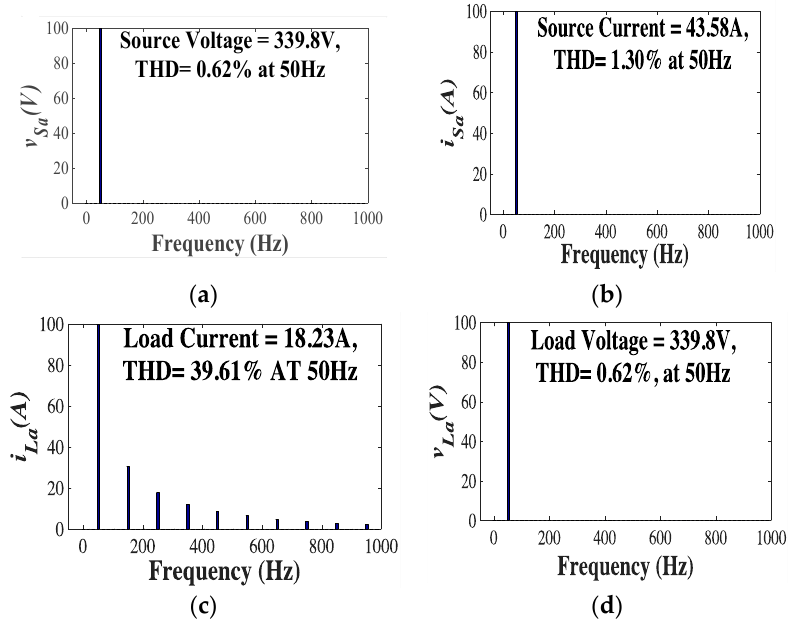
Figure 5. THD analysis of v Sa , i Sa , v La and i La . The comparison of the THD of selected source, load, and compensator signals with various adaptive VSC controls, e.g., MCC, AKWMCC and proposed control, are also presented in Table 1. Table 1. THD comparison of v Sa , i Sa , v La , i LA with MCC, AKWMCC and MRFKMP-based VSC controls.